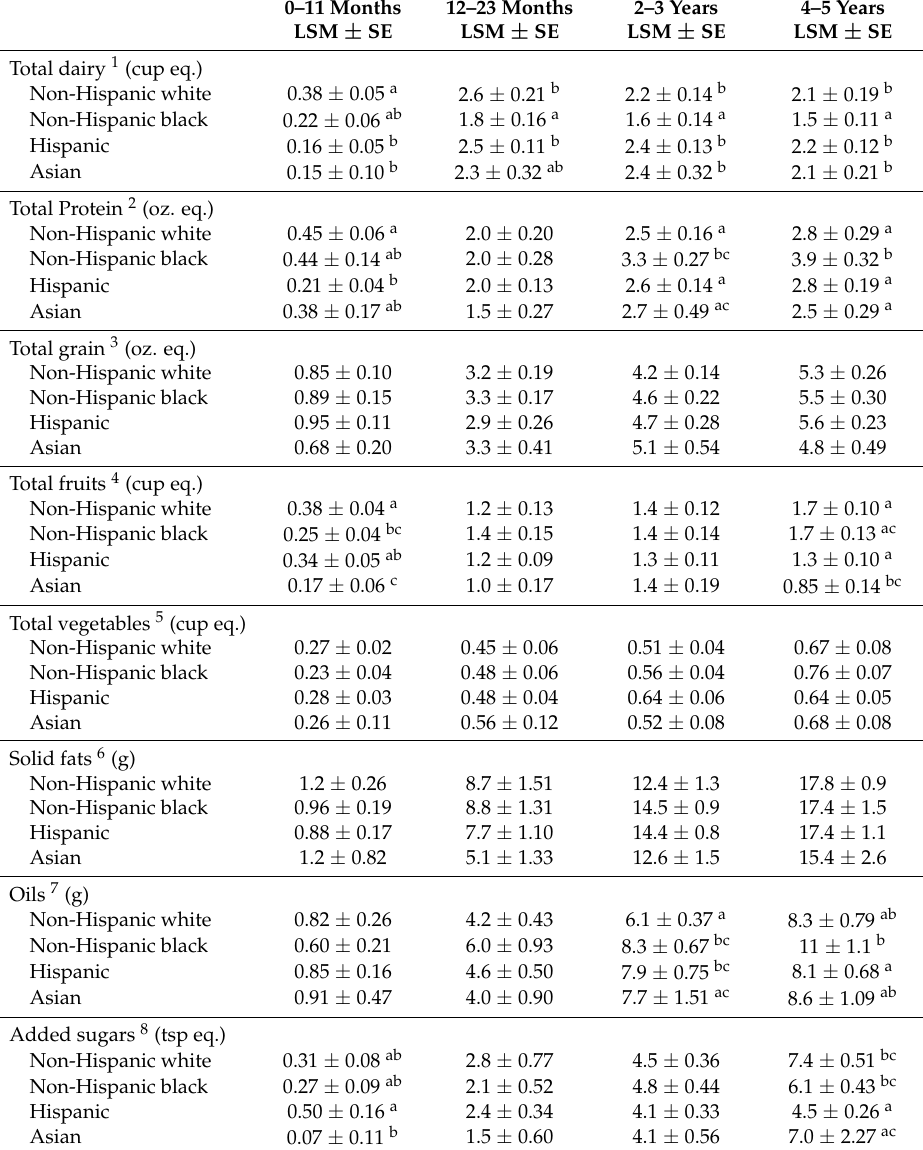
Table 3. Amount of food consumed per food group by age and ethnicity, NHANES